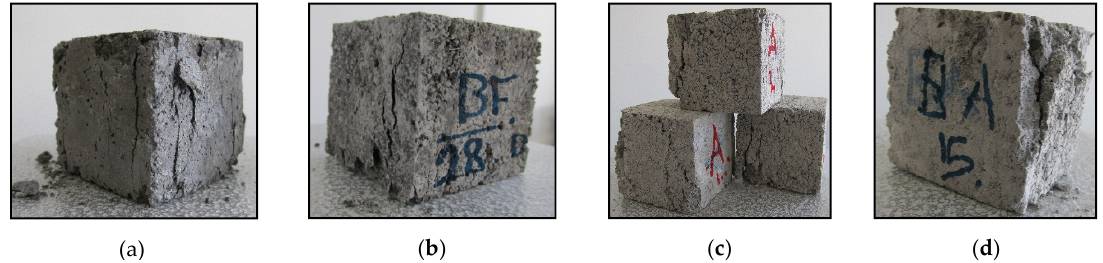
Figure 3. Failure pattern of samples under compression test ( a ) control sample, ( b ) BF-reinforced, ( c ) alginate mortar, ( d ) Alginate-BF mortar